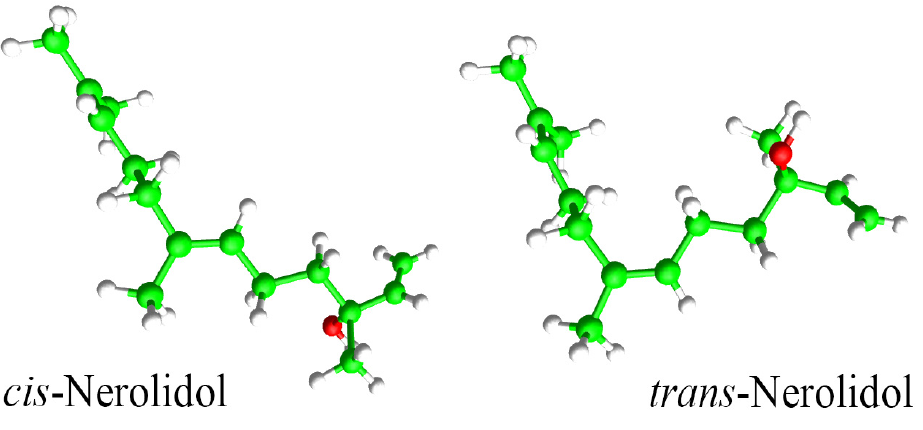
Figure 1. Chemical structure of nerolidol: cis -3,7,11-trimethyl-1,6,10-dodecatrien-3-ol and trans